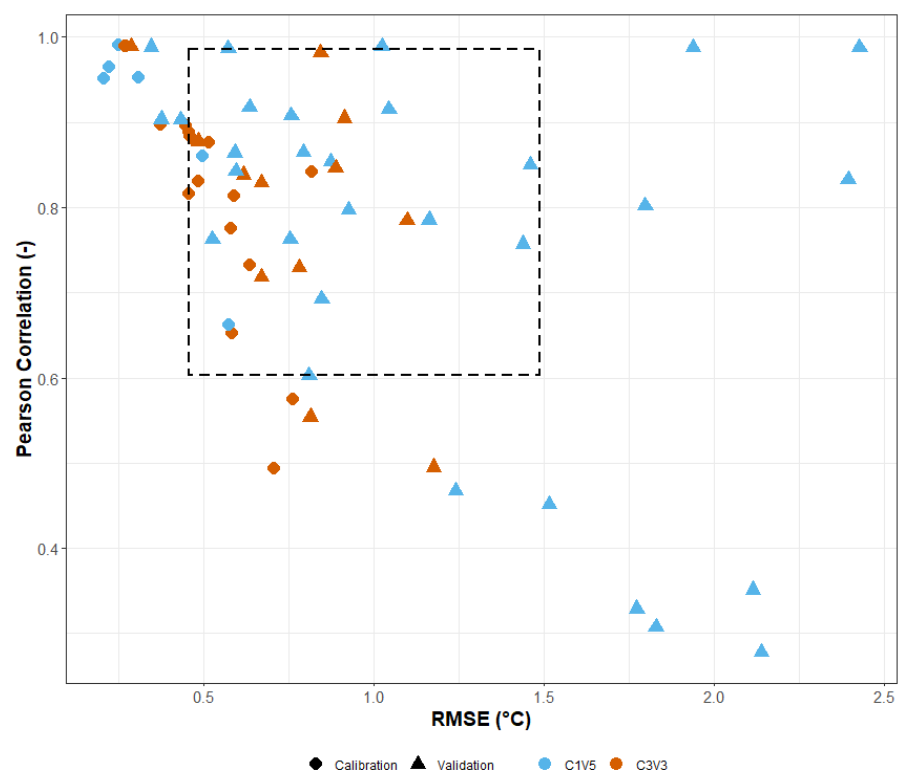
Figure 8. Scatterplots of Pearson correlations with respect to RMSE. Data grouped according to calibration approaches, i.e., for one week (C1V5) and three week (C3V3), using colour scheme and according to stage (blue for one week and orange for three weeks) and using data point shape for calibration or validation (circle for calibration period and triangle for validation period). Dashed box indicates the accuracy of WB model (see Section 4.2 for comparison with GB model).